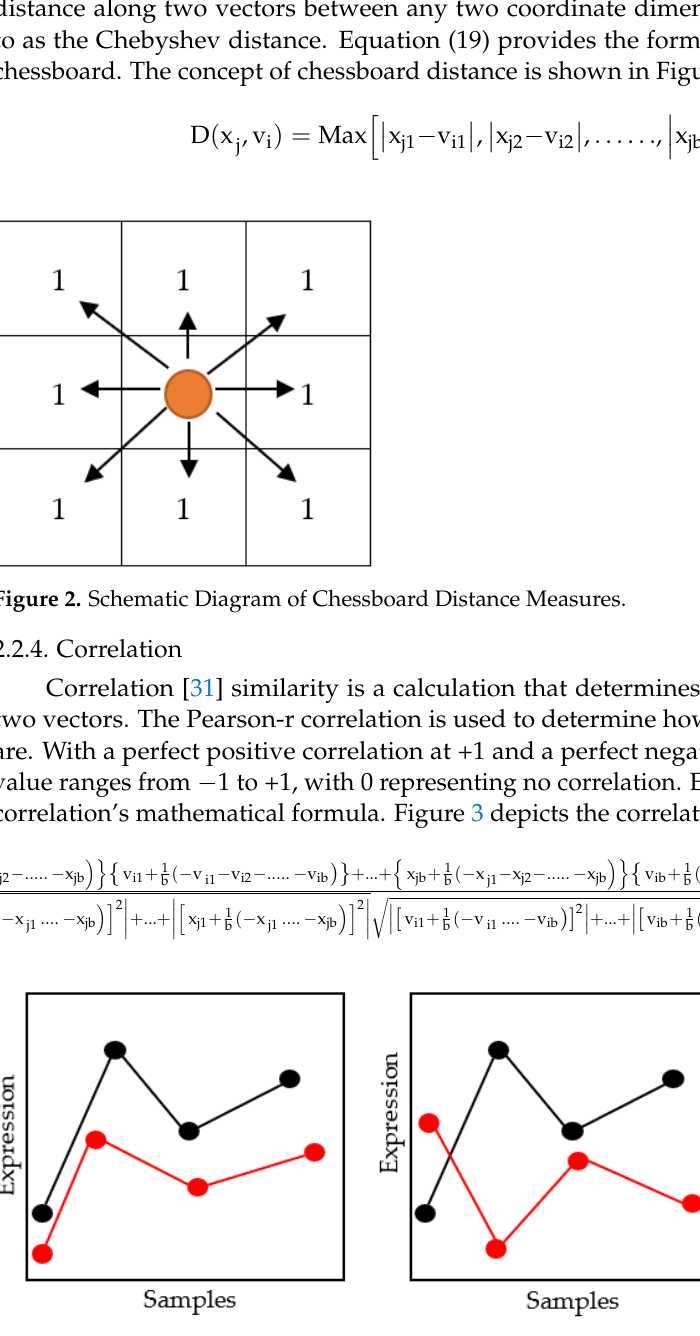
Figure 3. Schematic Diagram of Correlation Distance Measures.